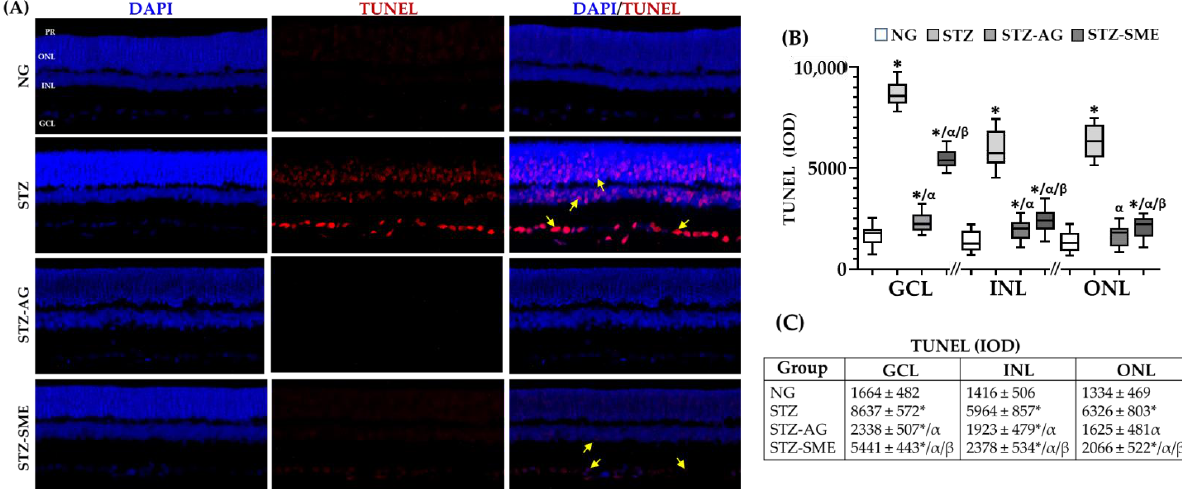
Figure 6. Effect of SME on the retinal degeneration of STZ. Apoptosis was determined by terminal deoxynucleotidyl transferase (TdT)-mediated deoxyuridine triphosphate (dUTP) nick-end labeling (TUNEL) assay in the NG, STZ, STZ-AG, and STZ-SME groups ( A ). Yellow arrows indicate representative cell apoptosis ( A ). The nuclei were stained with DAPI (blue). ( B ) The box-and-whisker plot of the IOD for the TUNEL staining in GCL, INL, and ONL. ( C ) Data shown in mean ± SD. * p < 0.01 compared to NG; α p < 0.01 compared to STZ; and β p < 0.01 compared to STZ-AG. Magnification 200×.